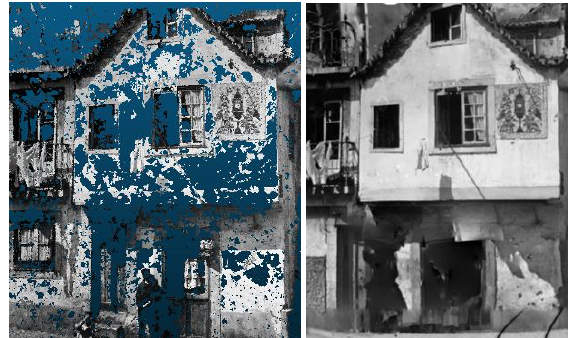
Figure 10. 3D photogrammetric reconstruction of case study Figure 12. Case study No.2: Rectification of the main building No.1, using archival photograph taken by unidentified author façades of using archival photograph taken by unidentified (n.d.). author